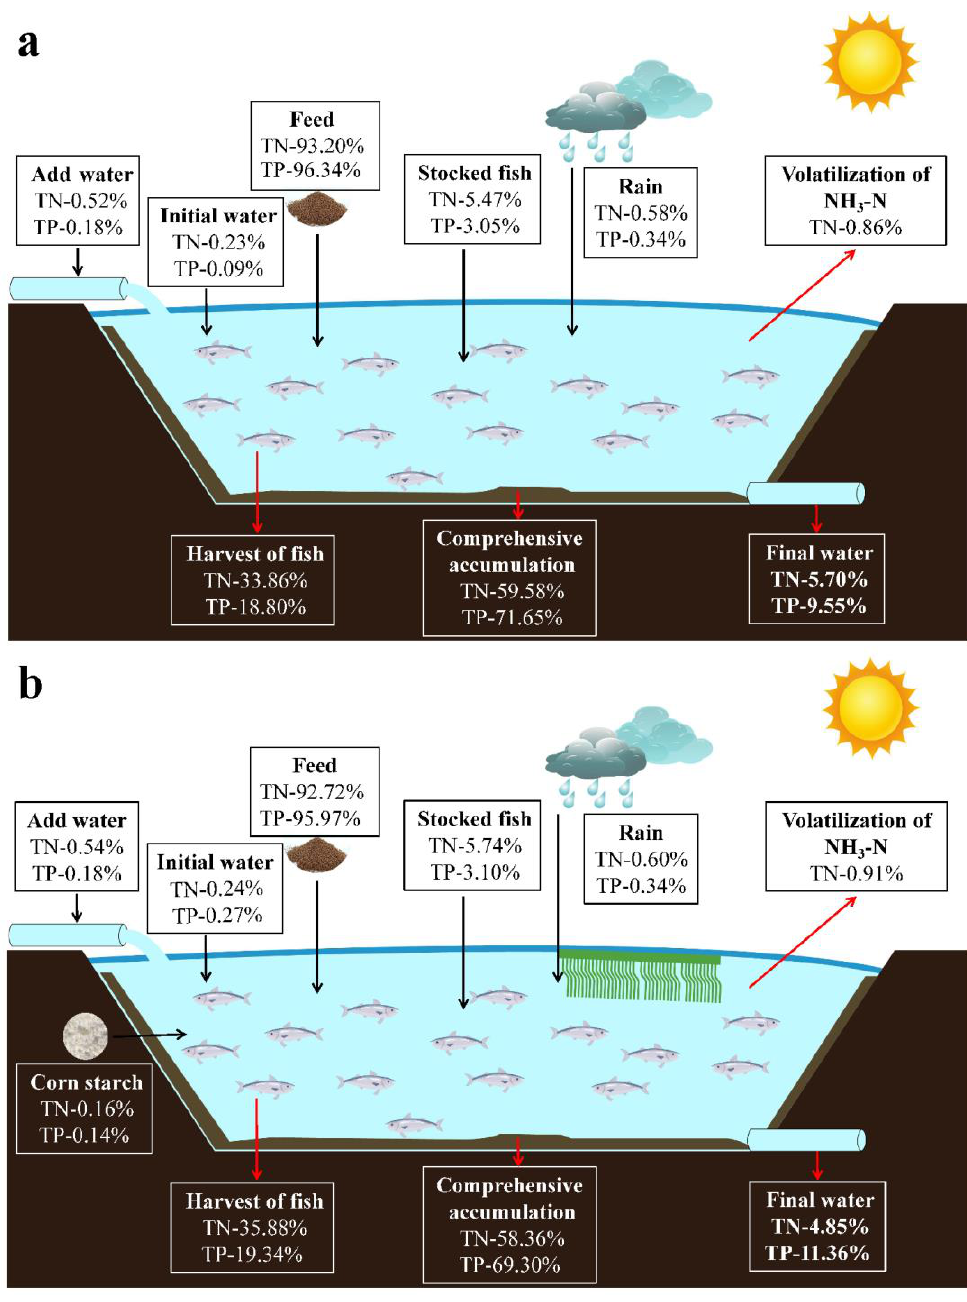
Figure 4. Nutrient budget in the control ( a ) and treatment groups ( b ). The main source of nitrogen and phosphorus was the feed. The nitrogen and phos- phorus feed inputs in the treatment group were both lower than those in the control group (92.72% and 93.20% of the nitrogen, respectively; 95.97% and 96.34% of the phosphorus,